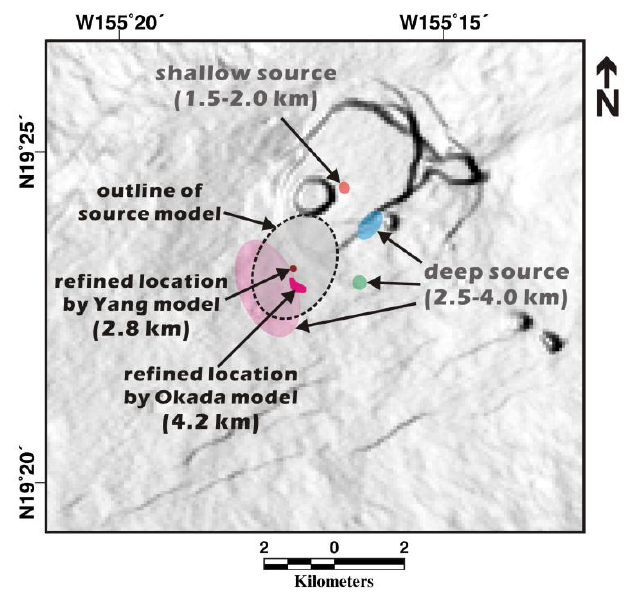
Figure 9. Refined magma source locations estimated from the 3D displacement maps using rectangular dislocation (Okada) model and prolate spheroid (Yang) model. Areas with colors indicate the source locations below Kīlauea’s summit, as defined by a previous study [20] and our results. The dashed outline represents the magma source boundary of the spheroid